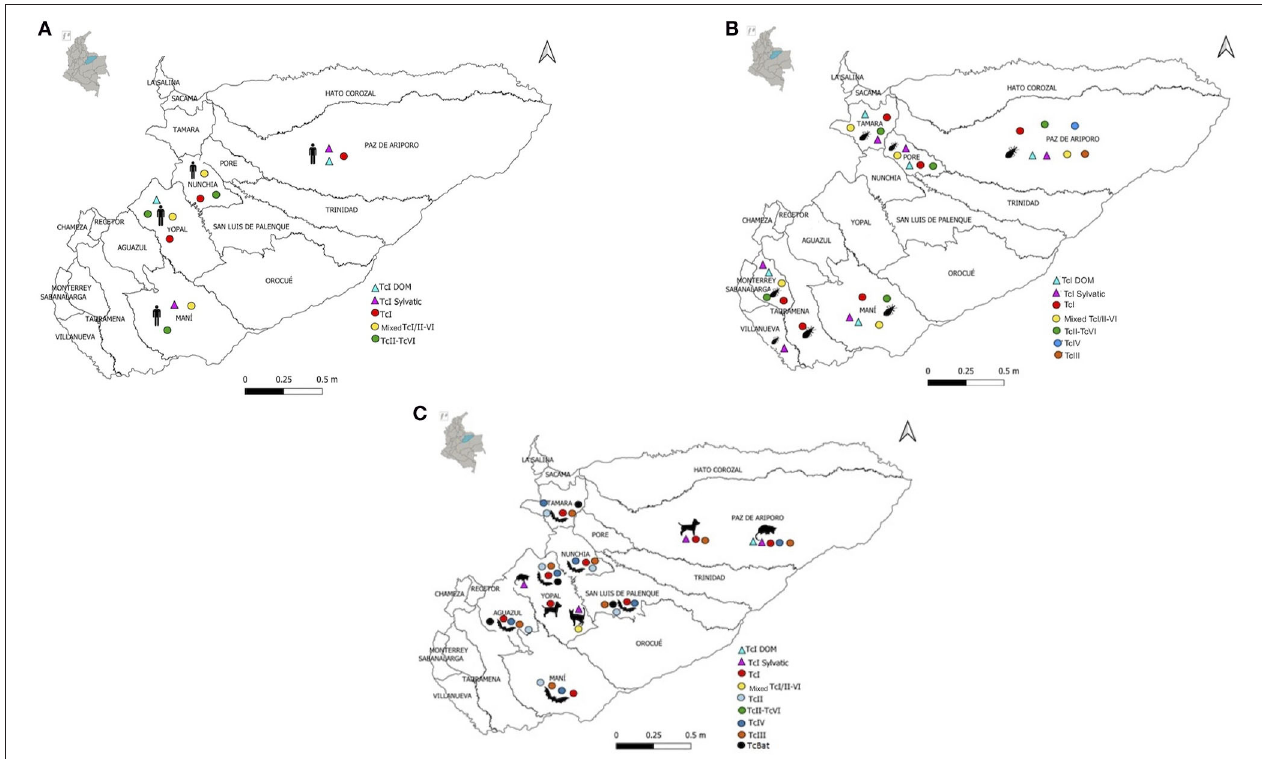
FIGURE 4 | Geographic distribution of DTUs identified in different Casanare species; (A) Distribution of DTUs in humans ( Homo sapiens ); (B) Distribution of DTUs in triatomines; (C) Distribution of DTUs in reservoirs ( Canis familiaris , Didelphis marsupialis , Felis catus ).